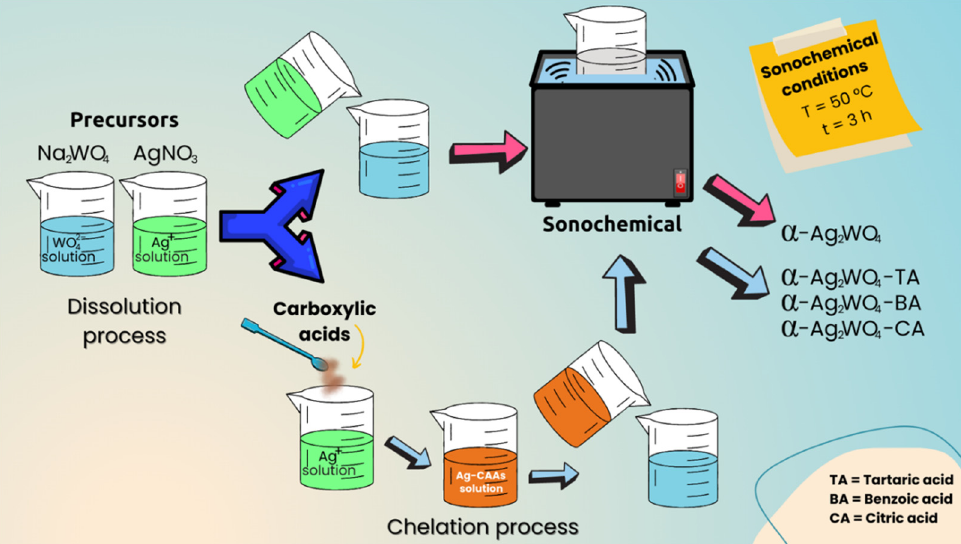
Figure 1. Illustration of the synthesis process of the α -Ag 2 WO 4 , α -Ag 2 WO 4 -TA, α -Ag 2 WO 4 -BA, and α -Ag 2 WO 4 -CA samples.